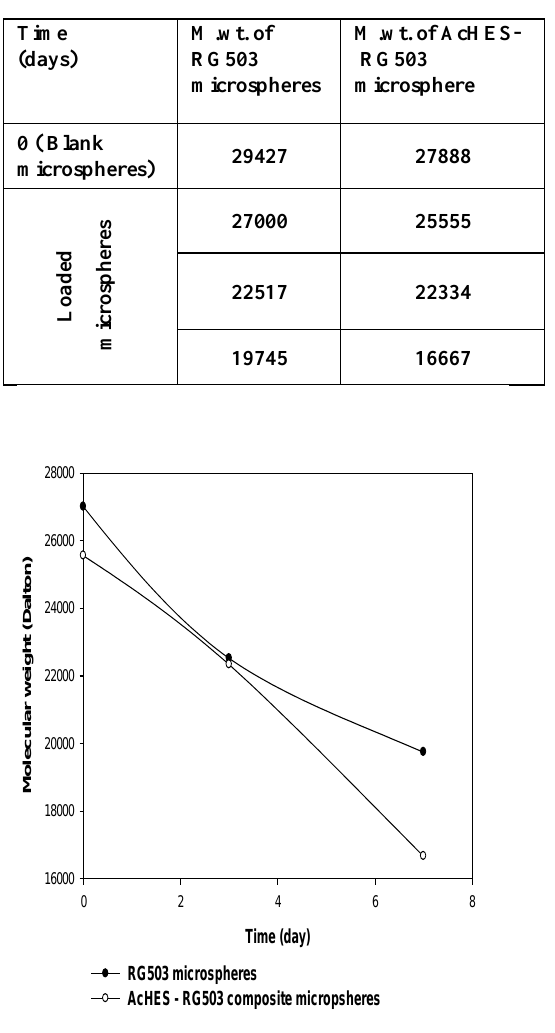
Table 3: Molecular Weight For The Blanks Microspheres And For KSL Peptide Loaded Microspheres Before And After Incubation In Phosphate Buffer Saline pH 7.4 At 37°C.